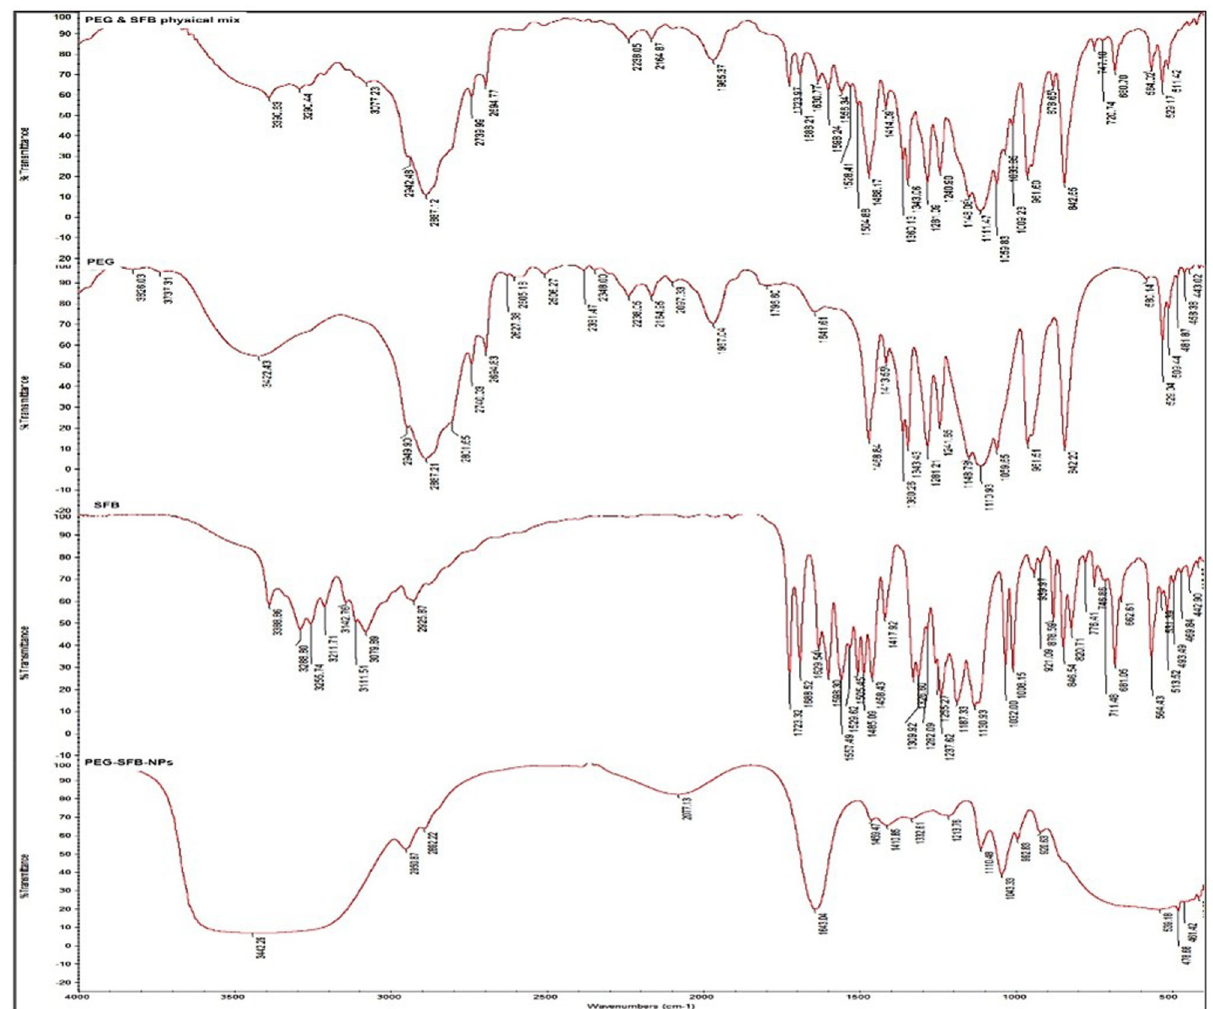
Figure 3: FTIR of PEG, SFB, physical mixture of PEG and SFB, and the formulated SFB -